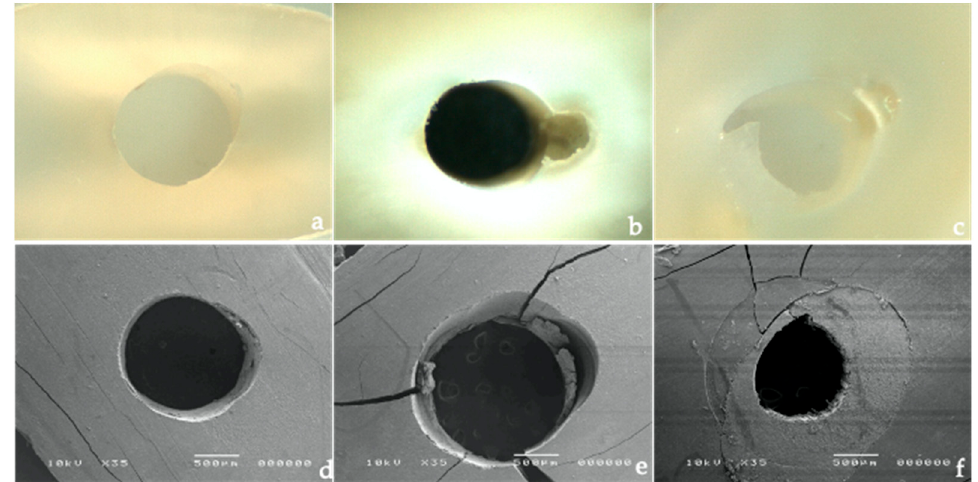
Figure 2. Failure modes of samples under the stereomicroscope × 10 magnification: ( a ) shows adhesive failure at the dentine (AD) by the clean wall; ( b ) adhesive failure at the resin/fiber post (AP) remnant of the resin cement in the canal walls; ( c ) mixed failure (M). Corresponding scanning electron microscopy images X35: ( d ) adhesive failure at the dentine (AD); ( e ) adhesive failure at the resin/fiber post; ( f ) mixed failure.